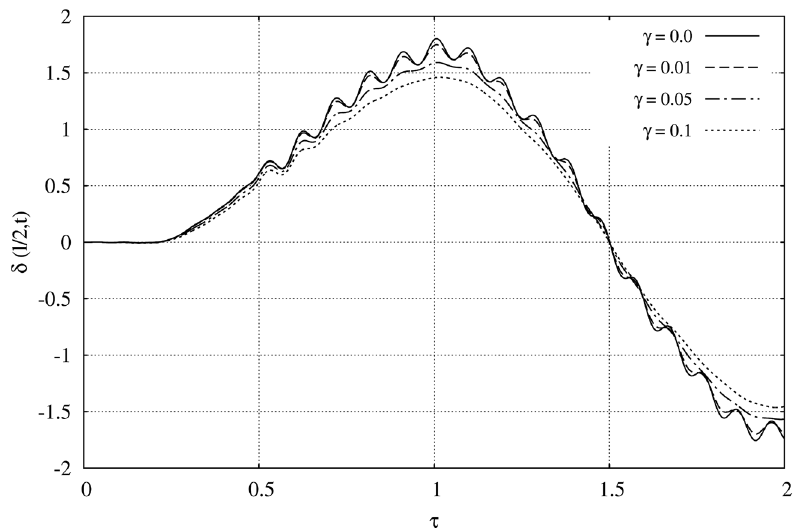
Figure 8 Time history of relative midsection deflection in resonance, l / d = 10, α = 1, k